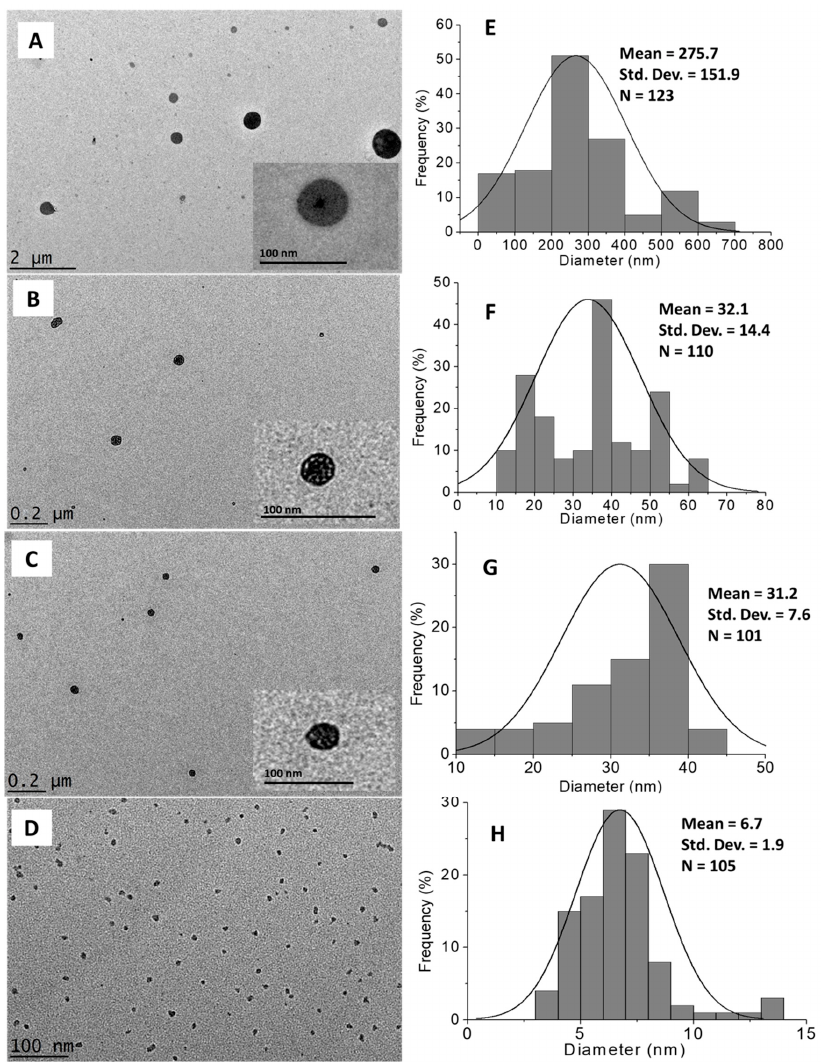
Figure 4. High-resolution transmission electron microscopy (HRTEM) images of the synthesized dazomet- loaded chitosan nanoparticles (CDENs) prepared at various concentrations of TPP: ( A ) 2.5, ( B ) 5, ( C ) 10, and ( D ) 20 mg/mL and their particle size distributions: ( E ) 2.5, ( F ) 5, ( G ) 10, and ( H ) 20 mg/mL.